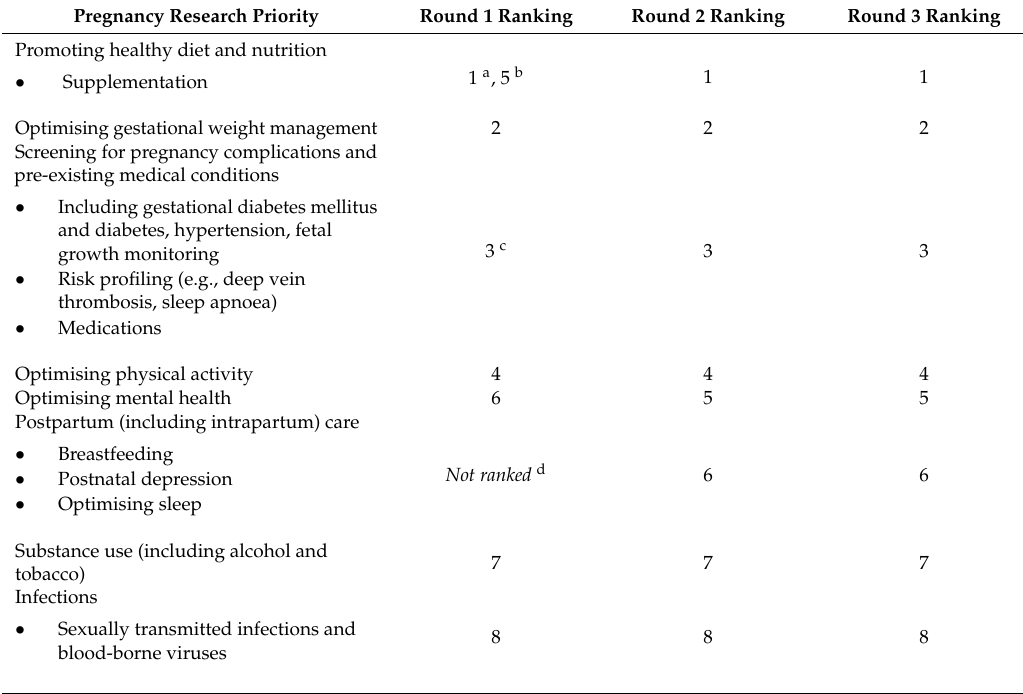
Table 1. Round 1, 2 and 3 pregnancy research priority